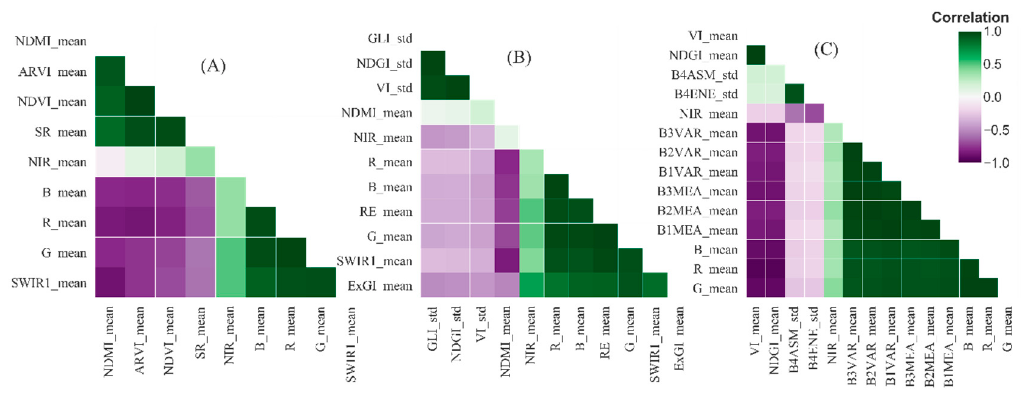
Figure 2. Intercorrelation among independent variables derived from ( A ) L8, ( B ) S2, and ( C ) PS images. See Table 4 for the descriptions of the notations used to represent the independent variables. Table 4. Correlation of relevant independent variables (see Tables 1–3 for definitions) derived from L8, S2 and PS images with AGB. The notations for SB and SI variables of all the image types are MMM_mean or MMM_std representing the mean and standard deviation of the variable MMM, in respective